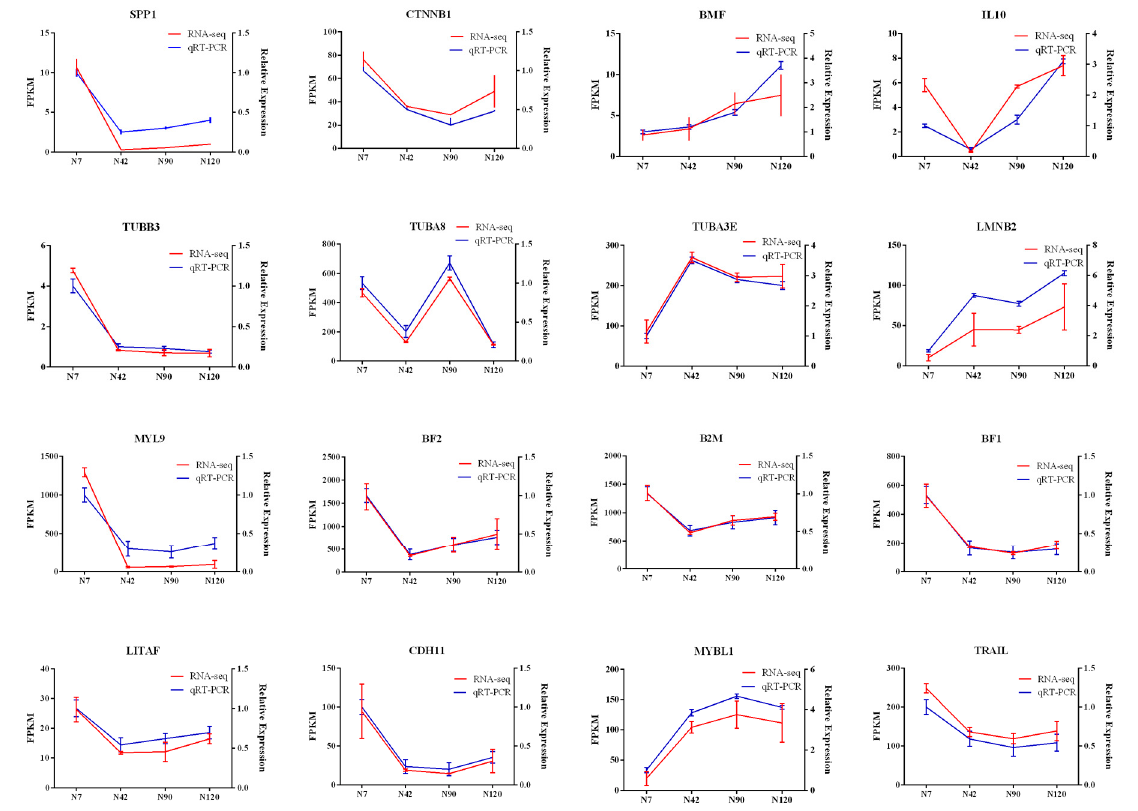
Figure 7. Expression levels of immune genes verified by both quantitative real-time polymerase chain reaction (qRT-PCR) and RNA sequencing (RNA-seq). chain reaction (qRT-PCR) and RNA sequencing